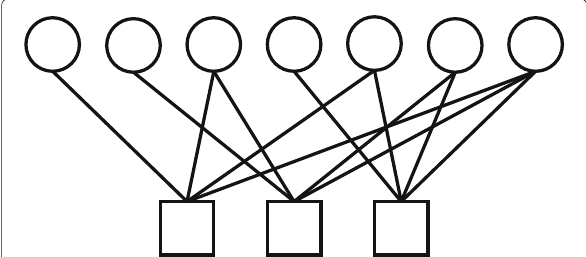
Fig. 1 Tanner graph example. Tanner graph for the (7,4) Hamming code. Circles are variable nodes, and squares are parity-check nodes. Nodes are connected via edges according to